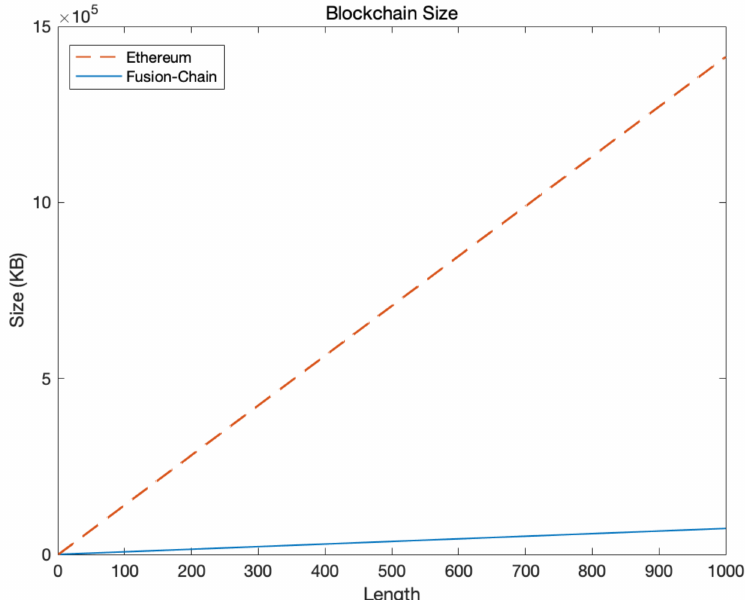
Figure 7. Blockchain